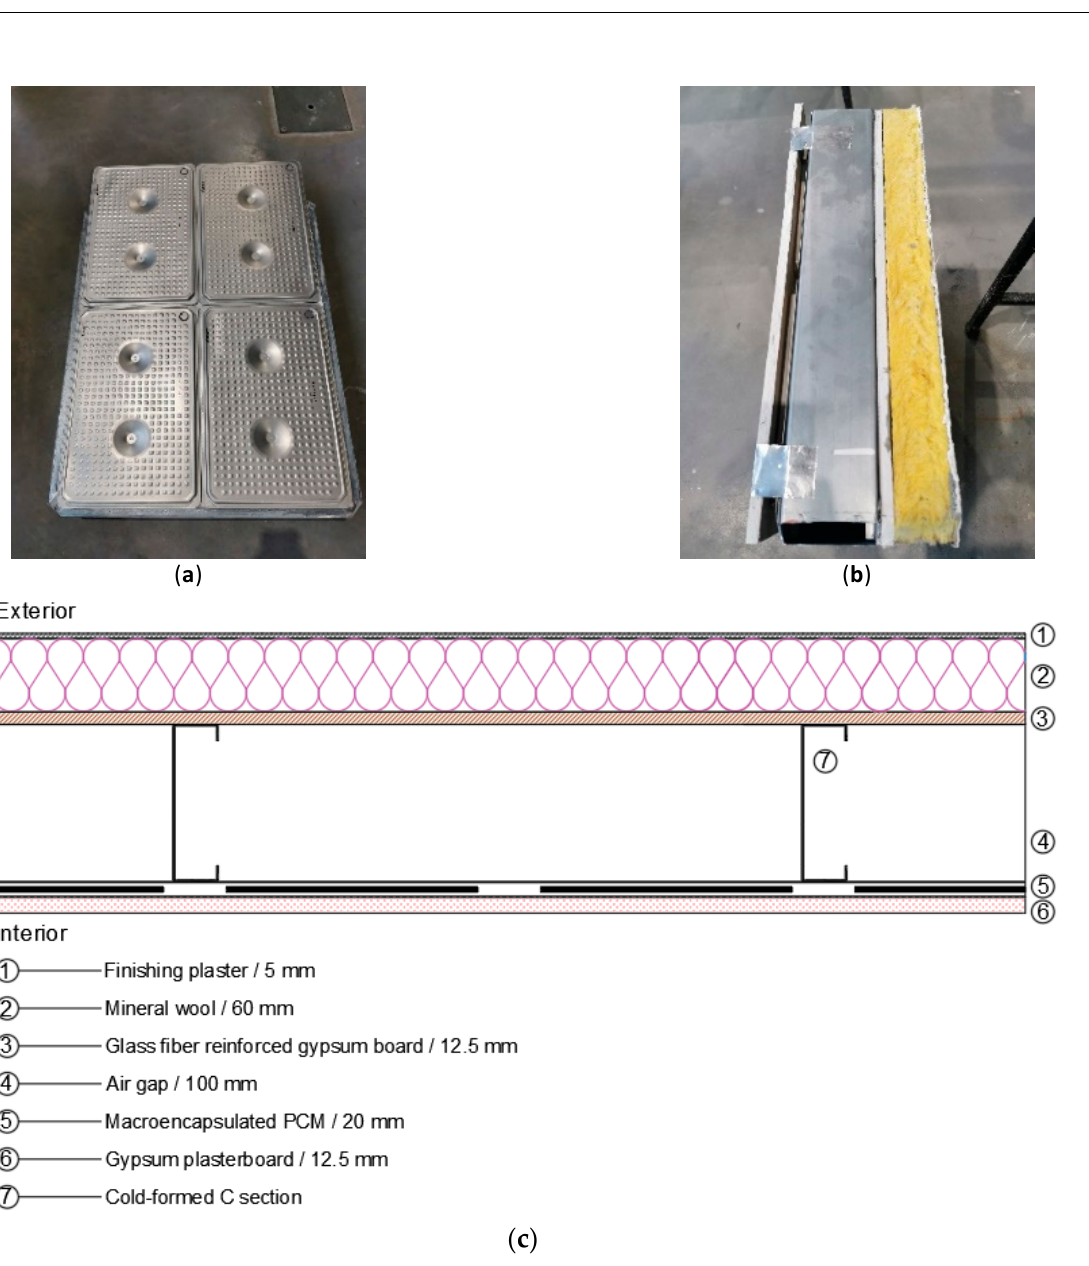
Figure 4. Construction solution of the envelope walls for the thermally enhanced tiny house (test cell): ( a ) macroencapsulated PCM with aluminum case; ( b ) cross section of the enhanced solution; ( c ) layered composition of the enhanced solution.